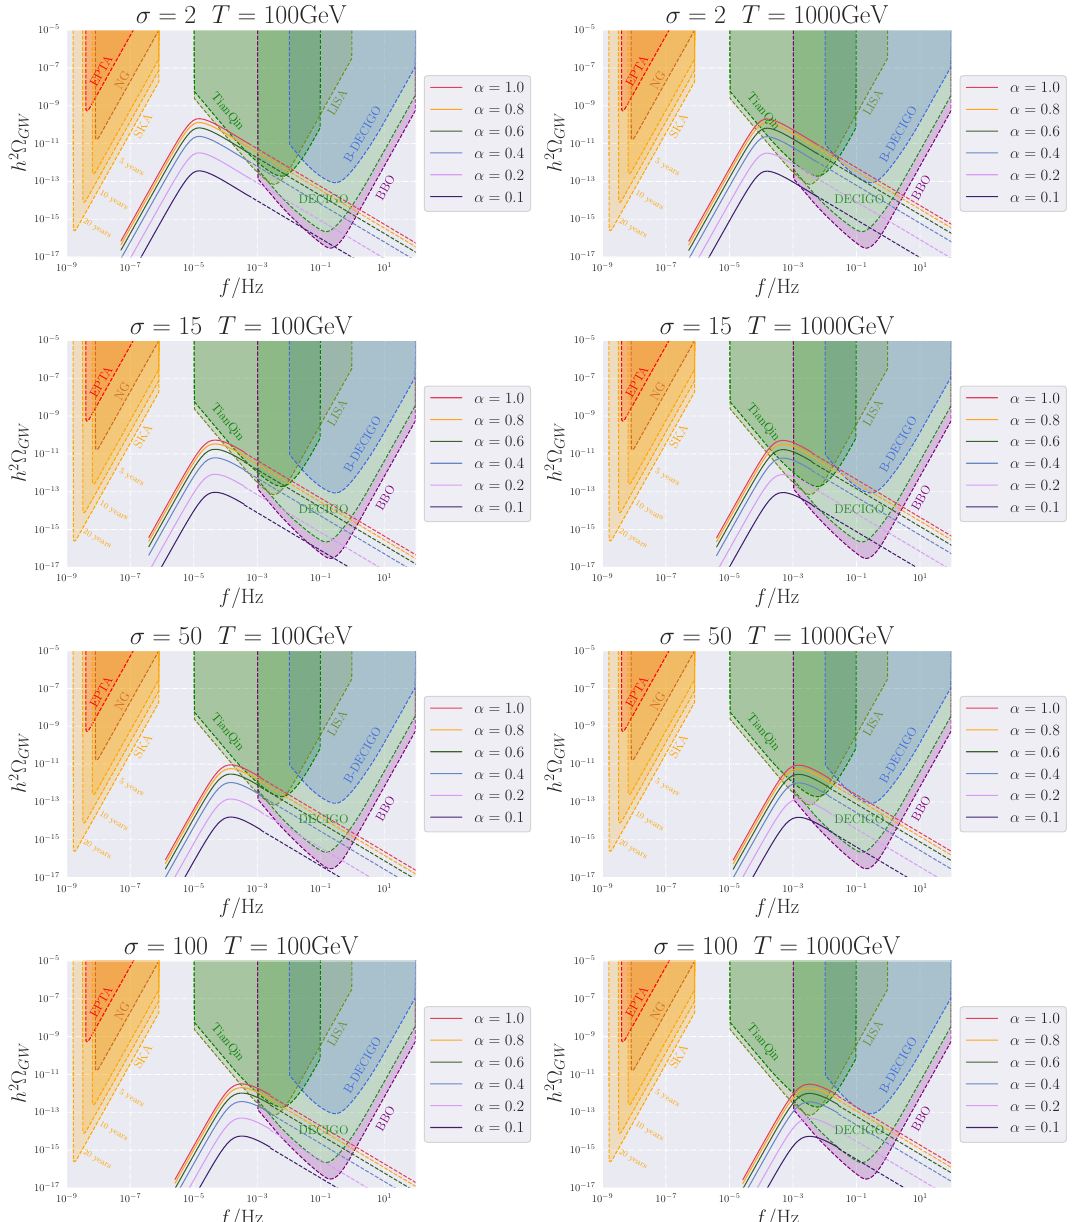
Figure 6 . Plot of GW spectra and PLI sensitivity curves [41] of EPTA [36], NanoGrav [3], SKA [23], TianQin [37], DECIGO [40], LISA [2], B-DECIGO [40], DECIGO [40] and BBO [11]. At here, we didn’t choose any specific model of phase transitions, so σ, T, α are three free variables which can change without restrictions. The solid lines are calculated by numerically integrating and dotted lines are given by